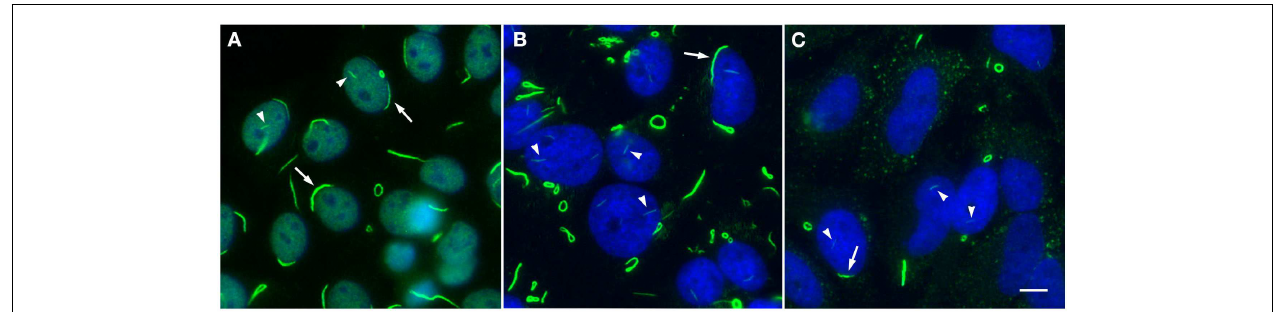
are recognized by serum It2006 (green, Alexa Fluor 488 goat anti-human IgG); nuclei counterstained with DAPI (blue). Under each condition, nuclear rods (arrowheads) can be clearly visualized alongside more conspicuous cytoplasmic rods and rings, which typically appear much longer and thicker than their nuclear counterparts; rings can also be found in the nucleus, although this is a less common observation. Additionally, while cytoplasmic RR appear to be more common than nuclear RR, rods often localize to the perinuclear region (arrows). All panels are shown at 200 × magnification. Scale bar: 10 µ m.